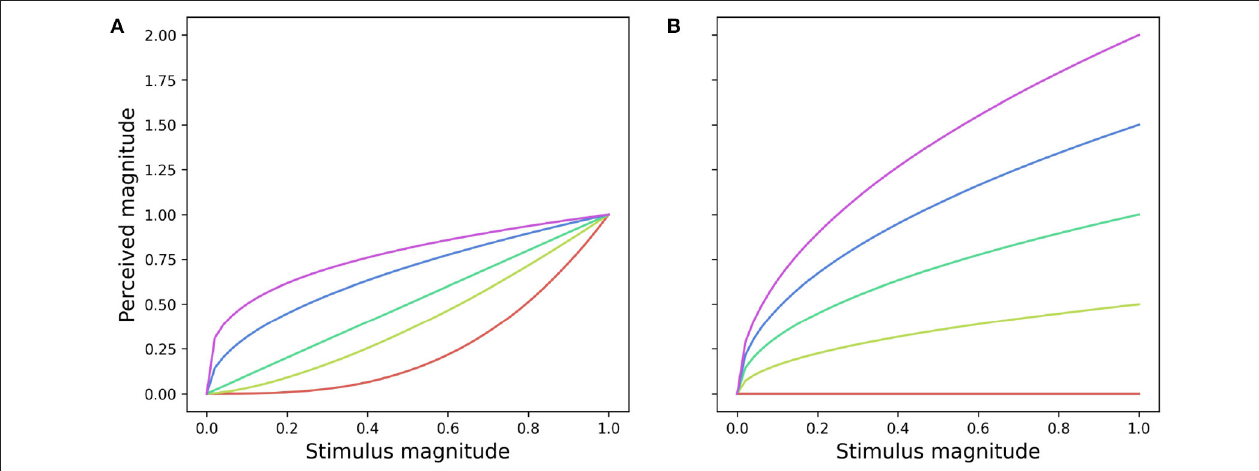
FIGURE 3 | Effect of coefficients a and m on the shape (A) and slope (B) of a power function (Equation 4) describing the magnitude of perceived change. (A) Effect of changing the value of m from 0.3 (red line) to 3 (purple line) for a 1.0. (B) Changes in the slope of a power function resulting from increasing the value of a from 0 = (red line) to 2 (purple line) for m =